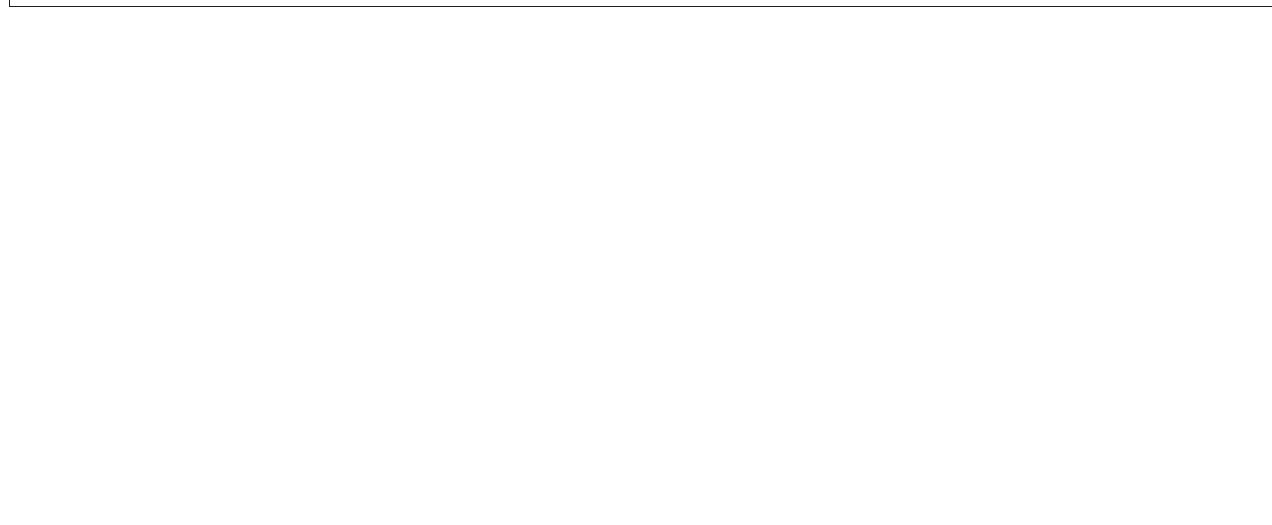
Frontiers in Nutrition |